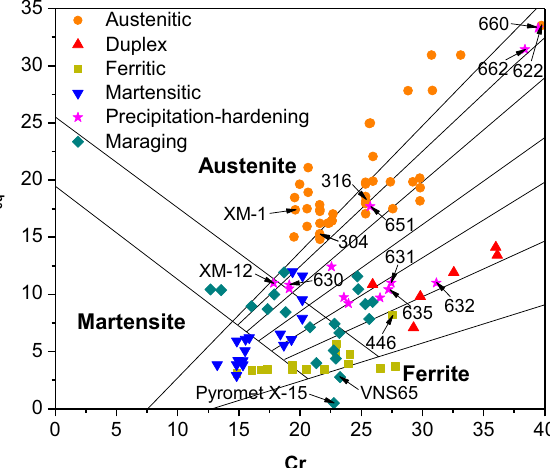
Figure 5. Common stainless steels analyzed by Schaeffler constitution diagram, according to ( a ) Delong’s equivalent coefficients; ( b ) our calculated equivalent